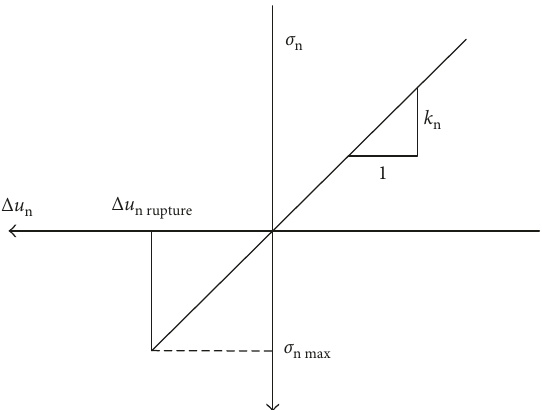
Figure 4: Normal stress displacement relationship on